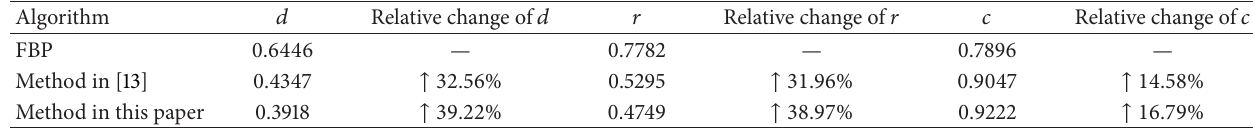
Table 1: Criteria values for the local reconstruction of the stacked particles phantom.